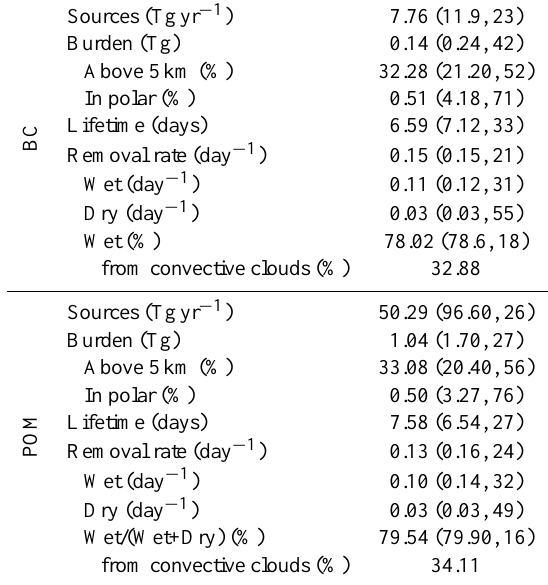
Table 3. Global annual budgets for BC and POM. The values in the parenthesis are the mean value (left) and standard deviation (right) from available models in AeroCOM (see Textor et al., 2006, Ta- ble 10). The standard deviation is normalized by the all models average in the percentage in AeroCOM.